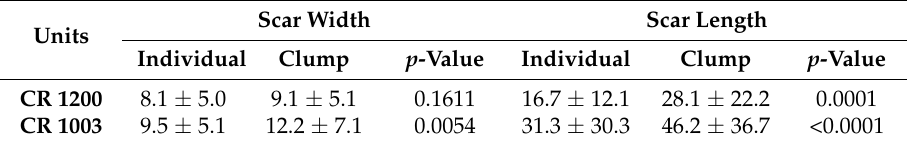
Table 6. Mean ( ± standard deviation) scar size (cm) of individual and clumped trees in each unit. Scar Width Scar Length Units Individual Clump p -Value Individual Clump p -Value CR 1200